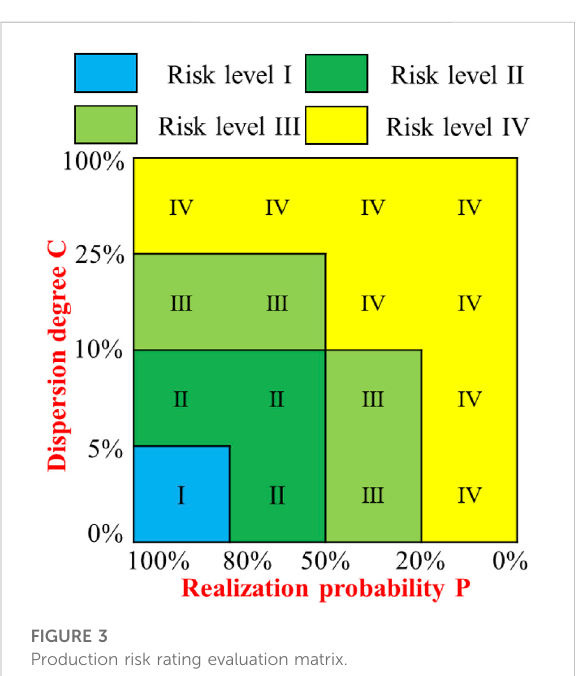
FIGURE 2 Monte Carlo method calculation steps.